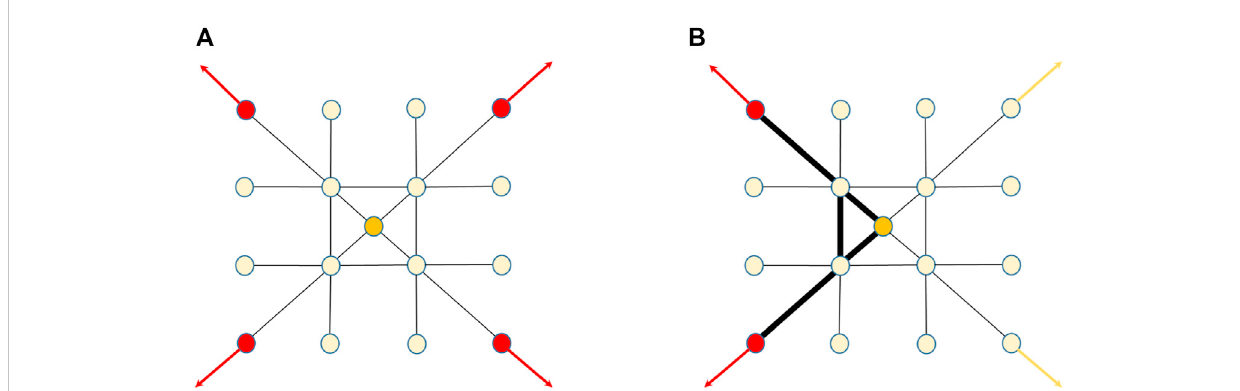
FIGURE 5 The pathsof higher infection probability amongnodes/individuals inacommunity. Theorangenode istheinfected individualstarting theepidemic; therednodesaretheindividualsthatmayactaspotentialspreadersofinfectionoutsidethecommunity,andtheredarrowsindicatethelikelytrajectories of the epidemic spreading outside the community. (A) A binary network where the four red nodes are all potential spreaders. (B) The weighted network counterpart of the binary network in (A) , where the most signi fi cant channels of infection emerge; in this weighted network, thepotential spreaders to consider are the two red nodes only, and the likely trajectories of infection outside the community are only two (red